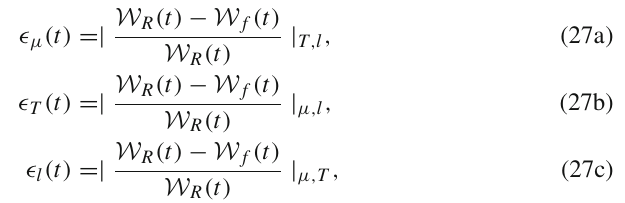
V ( l ) = − 114 . 55 ( − 0 . 1017) for left (right) graph. The dashed red curve shows our numerical results and the blue sine curve is the fitted function